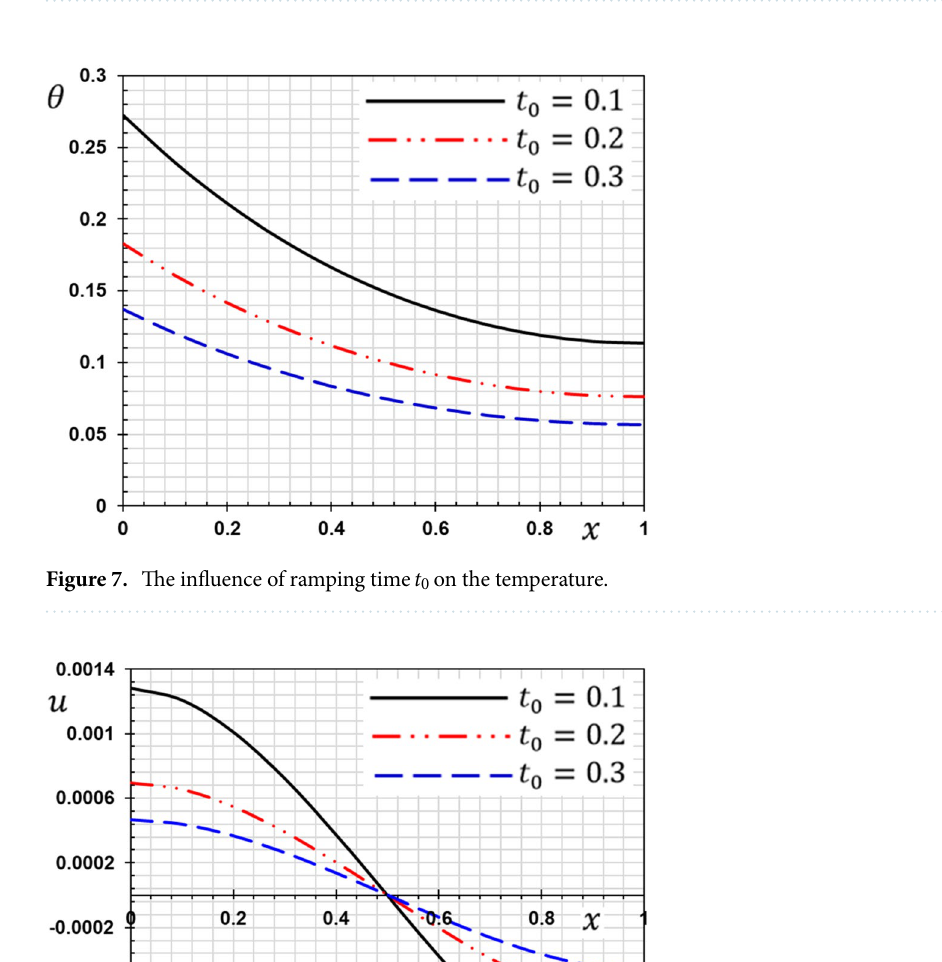
Figure 6. The influence of ramping time t 0 on the transverse deflection.